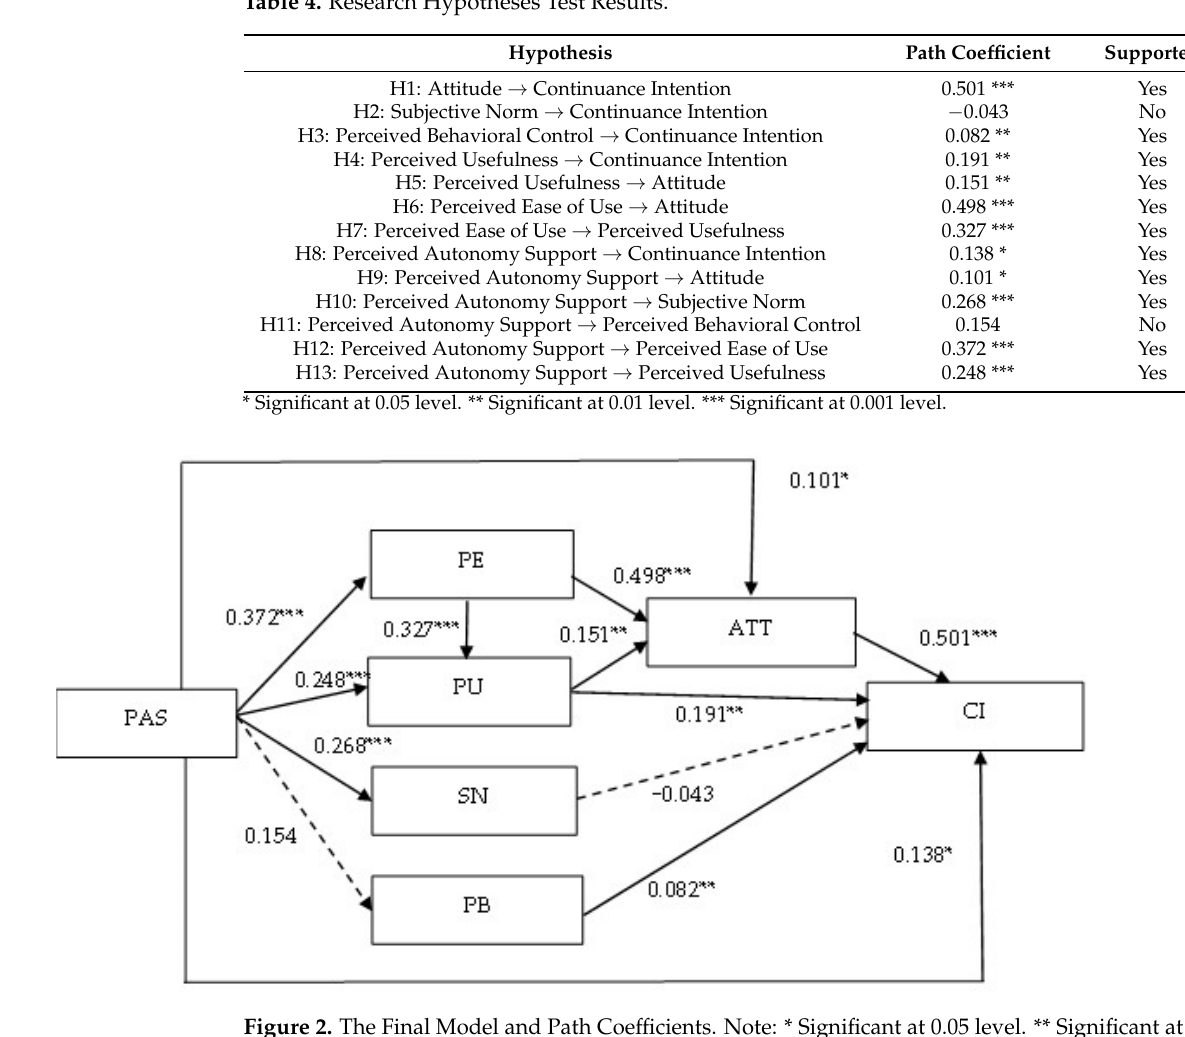
Table 4. Research Hypotheses Test Results.